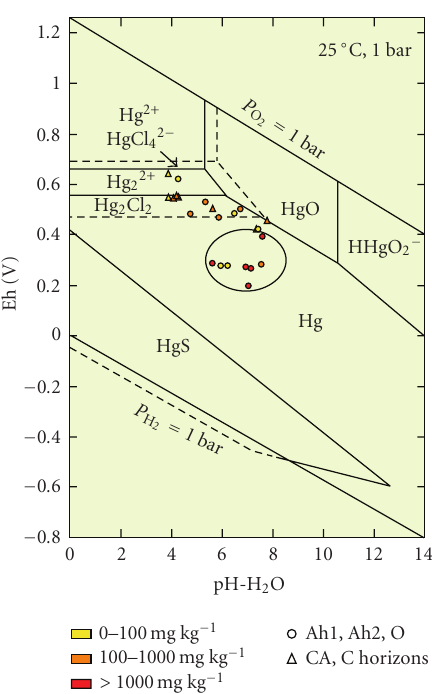
Figure 4: Mercury Eh-pH diagram for an Hg-O-H-S-Cl system. Values of Eh and pH of selected soil samples are displayed. The assumed activities for dissolved species are Hg: 10 − 8 M, Cl: 10 − 3 . 5 M, and S: 10 − 3